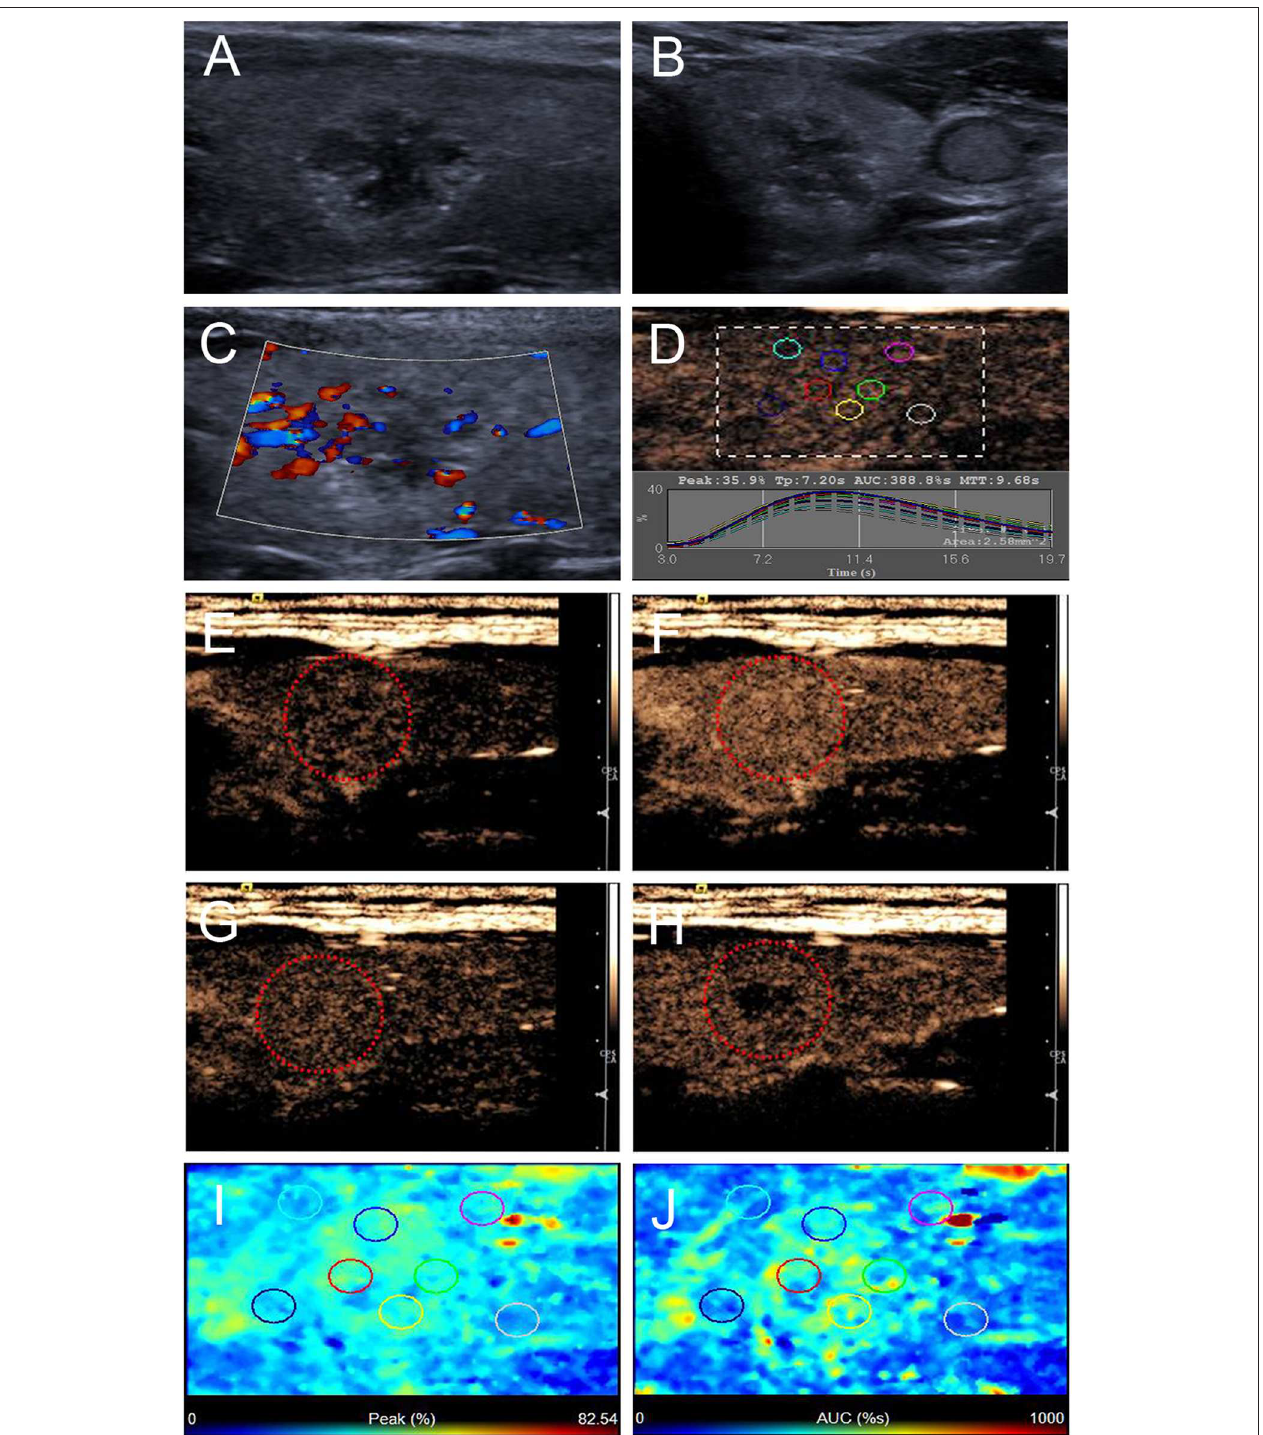
FIGURE 3 | Ultrasound images of a 26-y-old female PTC patient with petal-like calcification of the left thyroid lobe. (A) Longitudinal and (B) horizontal gray-scale sonograms; the thyroid nodule had a solid component, hypoechoic echogenicity and ill-defined margin. (C) Color Doppler sonogram showed moderate peripheral vasculary. (D) TICs of the thyroid nodule and peripheral thyroid parenchyma with different regions of interest (different color circles). (E–H) CEUS sonograms of the thyroid nodule (E) at 6s (wash-in), (F) 9s (time to peak), (G) 15s (wash-out), and (H) 33s (wash-out), revealing diffuse and homogeneous enhancement (circle) across the whole lesion, and the center of the lesion washed out clearly at 33s. (I) Parametric color map showing that peak intensity values for the nodule were partially green, and the adjacent thyroid parenchyma was blue, indicating that the peak intensity of the nodule was higher than that of the peripheral thyroid parenchyma. (J) Parametric color map showing that AUC values for the nodule were mixed with green and yellow, and adjacent thyroid parenchyma was blue, indicating that the AUC of the nodule was higher than that of the peripheral thyroid parenchyma.